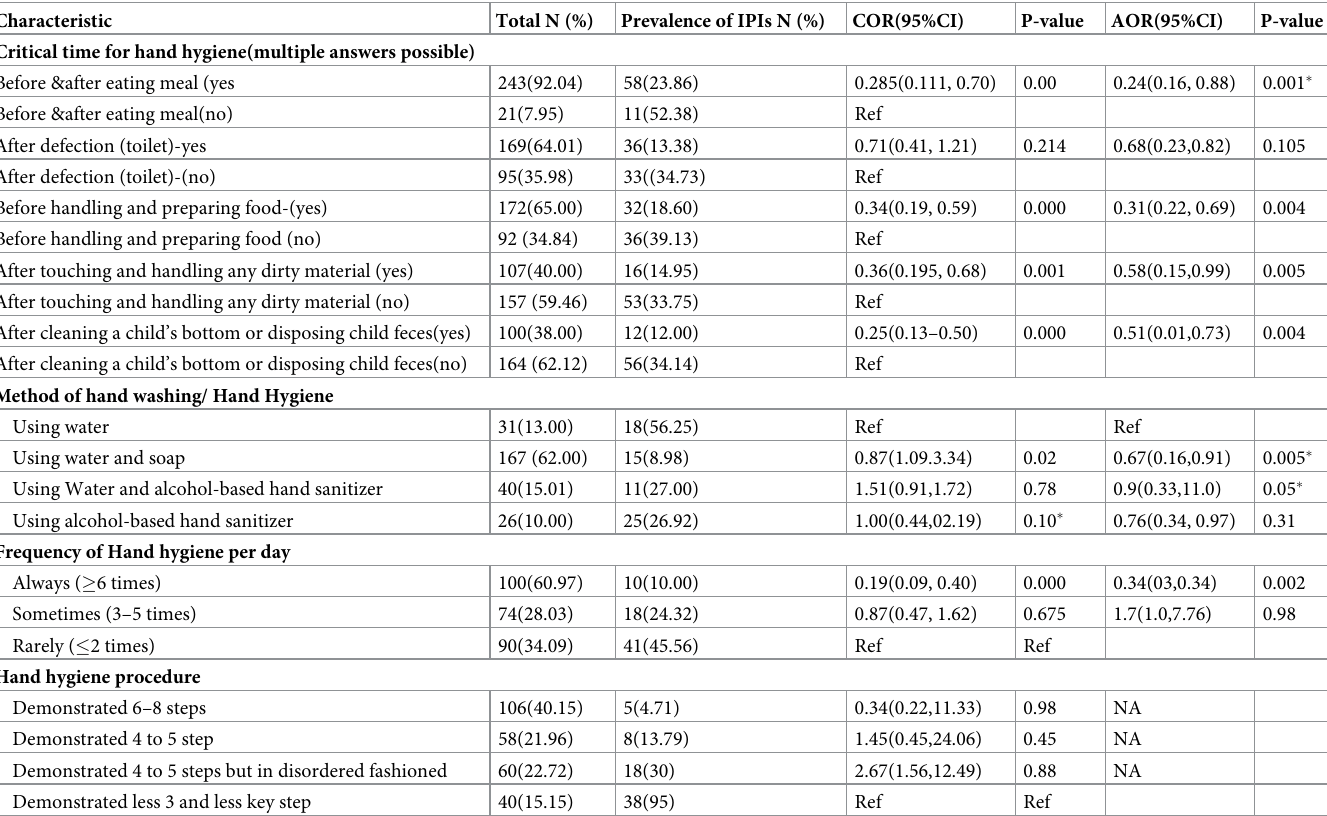
Table 5. Bivariate and multivariate analysis of hand hygiene practice with risk of intestinal parasitic infection among patients attending Arba Minch general hospi- tal outpatient department during COVID 19 pandemic, southern Ethiopia (from June to September 2021).